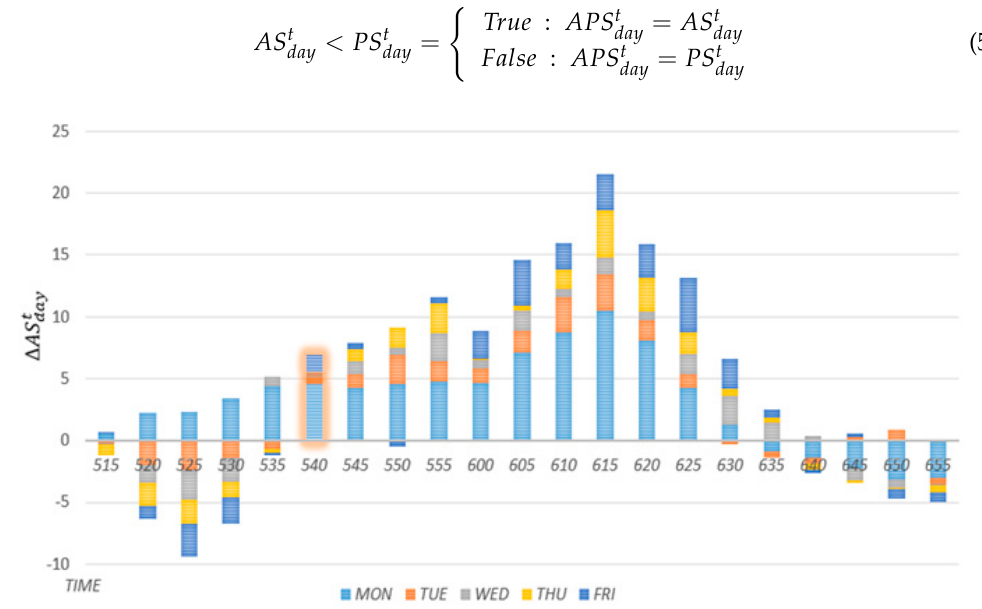
Figure 8. Historical speed changes during the rush hours for each day of the week.